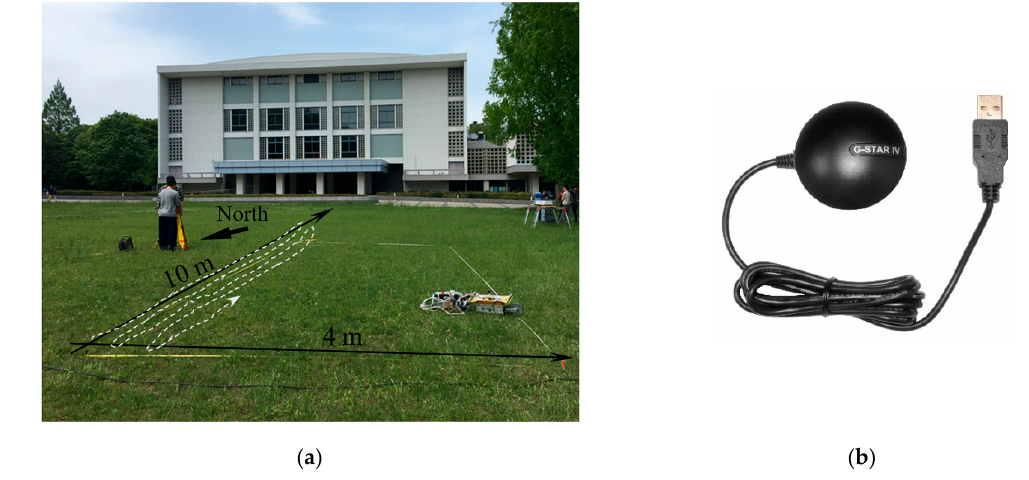
Figure 1. ( a ) Surveying scenario of the Metasequoia trees using the proposed 3D GPR system. ( b ) The low-cost GlobalSat GPS receiver used in this investigation. Table 1. System parameters of the RAMAC 500 MHz Shielded Antenna system used for investigation purposes [27].